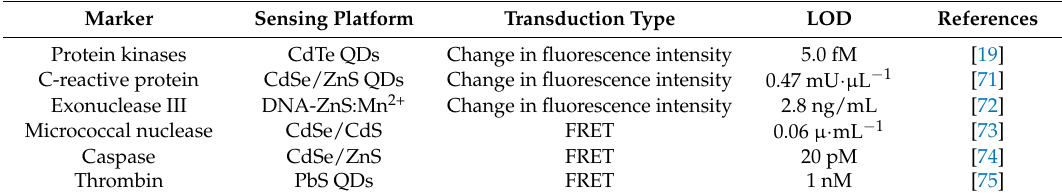
Table 3. QDs-based sensors for proteins